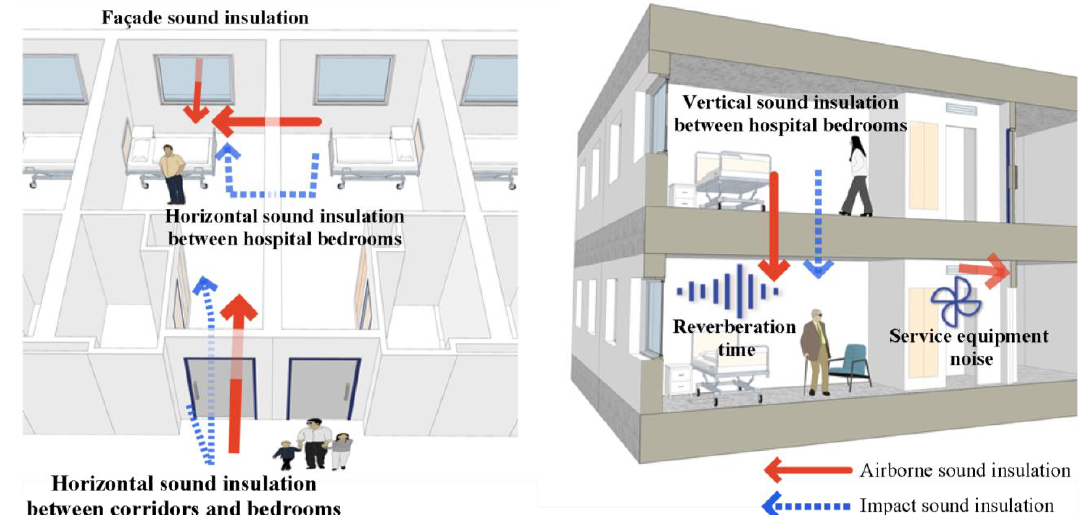
Figure 1. Acoustic requirements for hospital bedrooms analysed for selected countries in Europe.